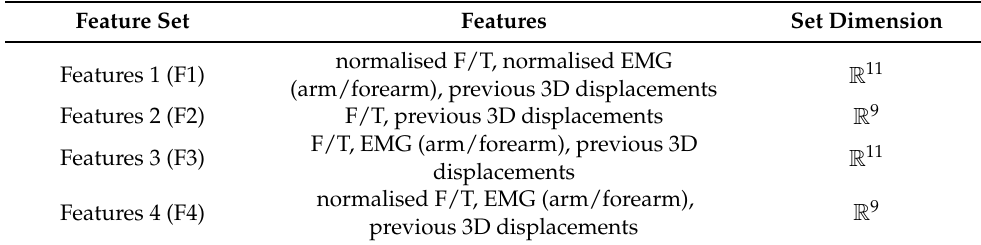
Table 1. Feature sets utilised to fit data-driven models.